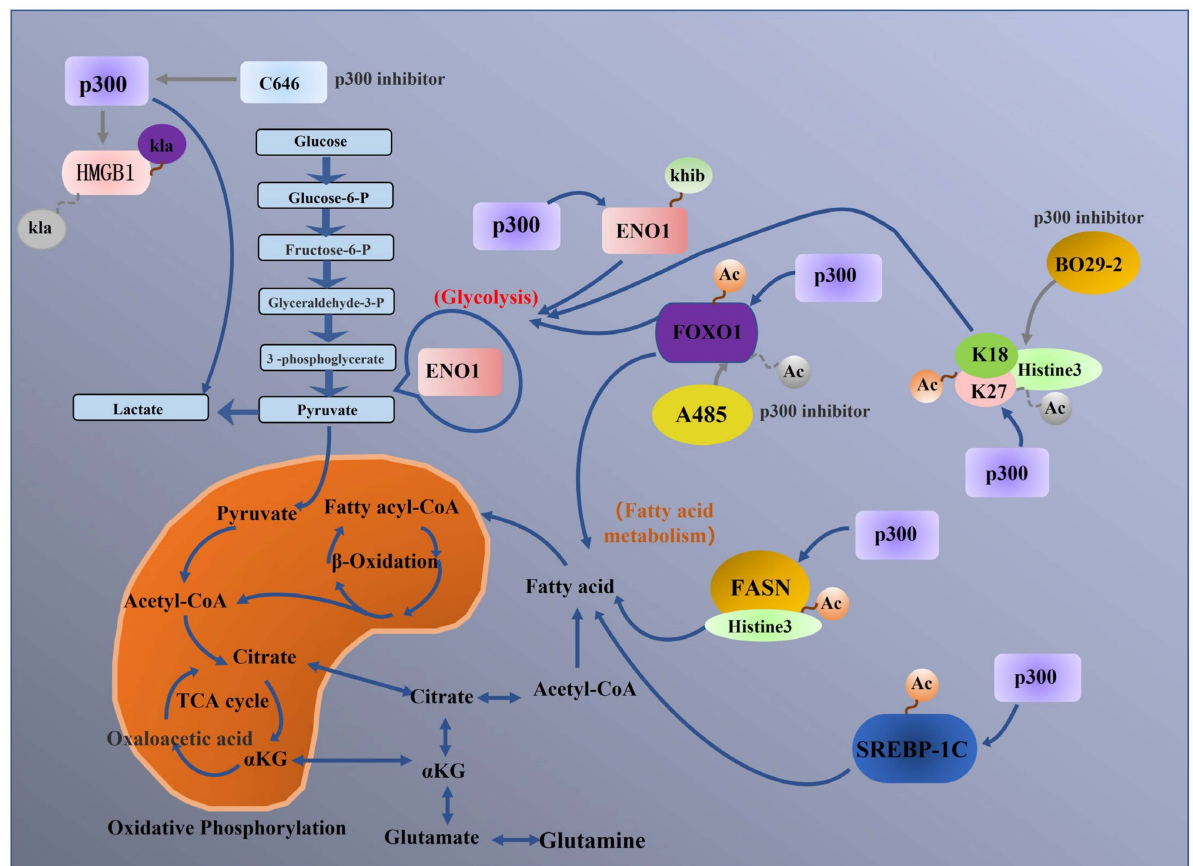
Figure 6. Schematic diagram of the mechanisms of p300 in tumour metabolism regulation. p300 catalyses many different types of posttranslational modifications, such as acetylation, β - hydroxyisobutyrylation and lactylation, in tumour cells to modulate glycometabolism and lipid metabolism. (Remarks: The grey arrow is the related process in which p300 inhibitors participate in regulation, and the dotted line is the process in which modification types are